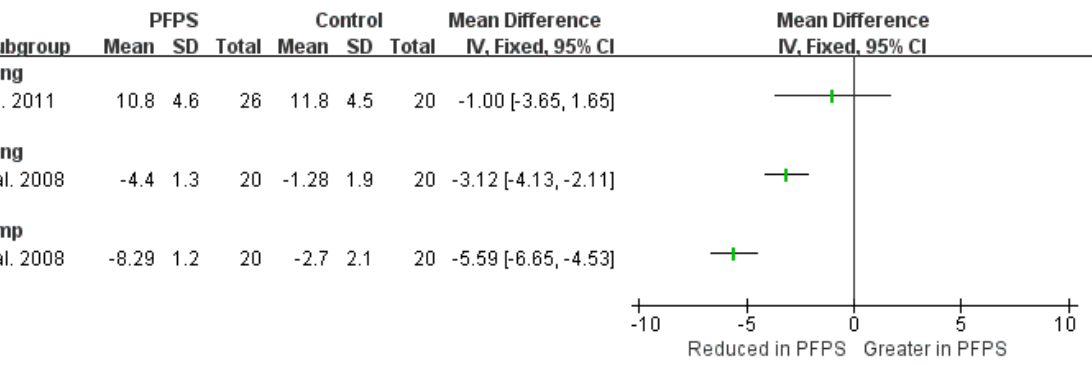
Figure 7. Knee internal rotation angle between the PFPS and control group among the various functional activities. 3.5. Hip strength and torque.